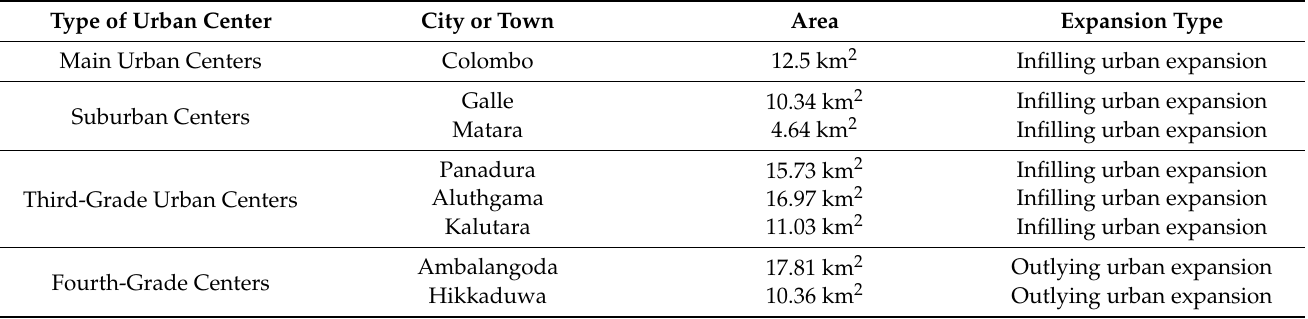
Table 7. Identified urban centers and expansion types of adjacent urban